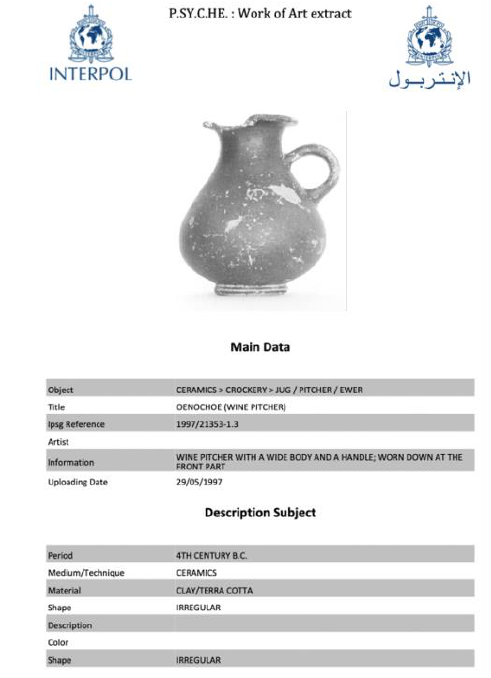
Figure 3. Training Dataset, Interpol Datasheet Sample